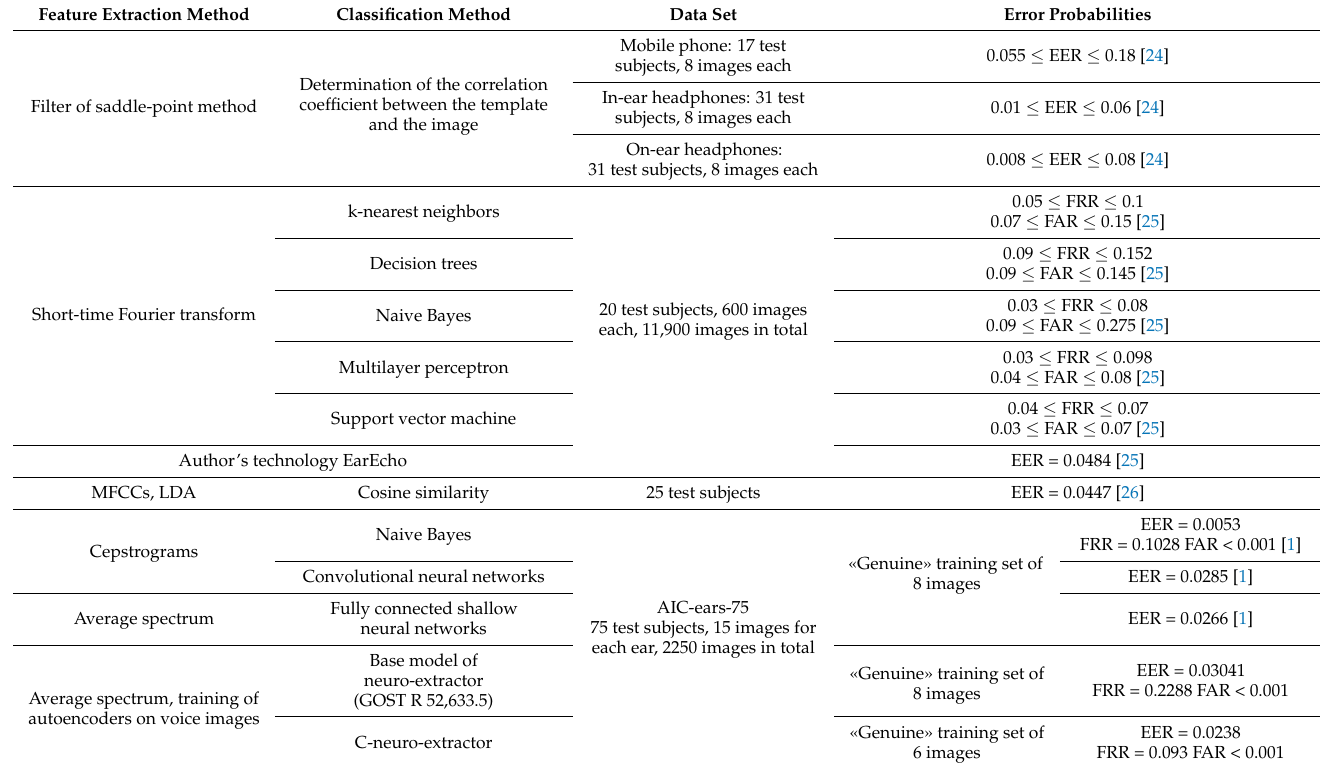
Table 7. Results of personality recognition by the ear